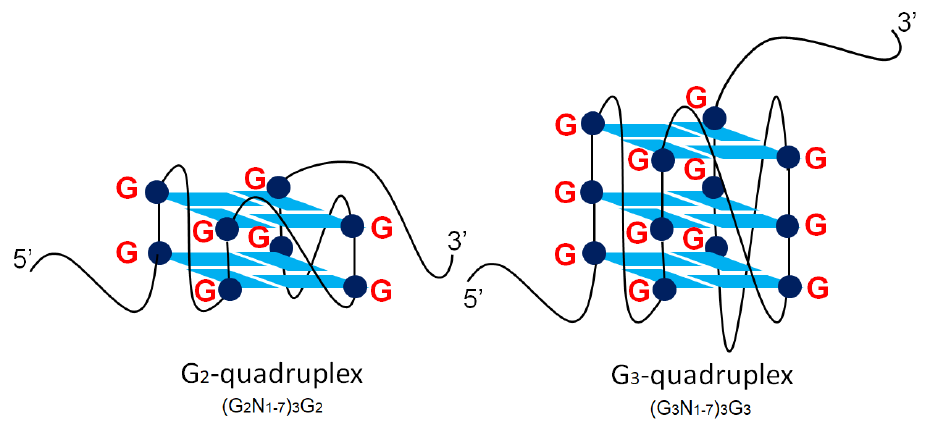
Figure 1. Schematic diagram of the G 2 -quadruplex and the G 3 -quadruplex.